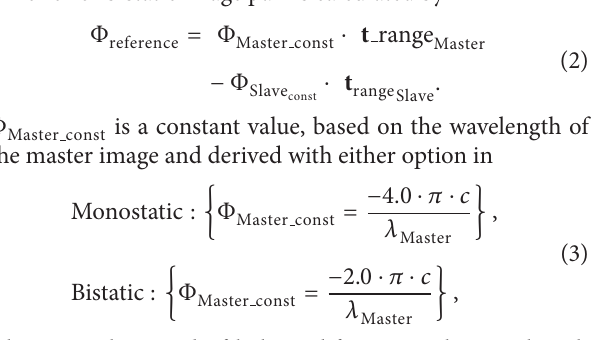
Figure 4: Relation of baseline annotations and orbit geometry for